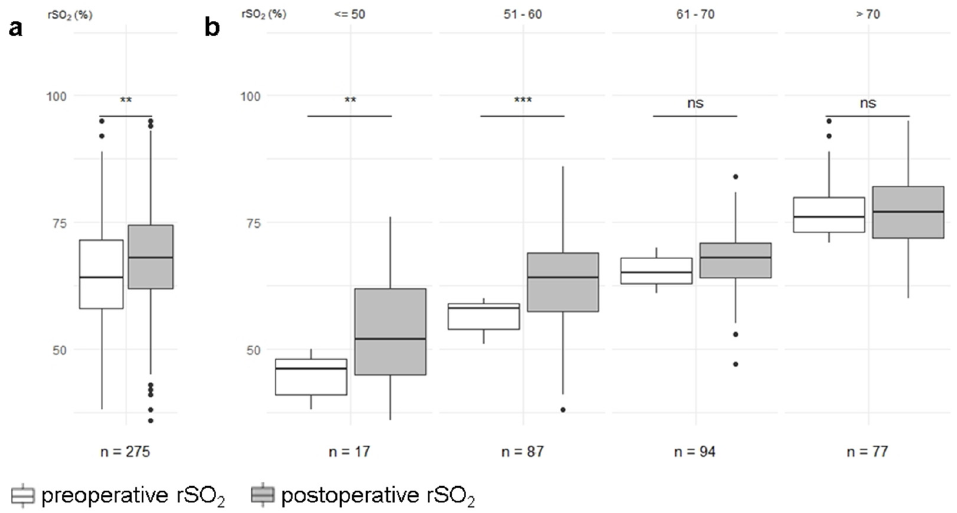
Figure 2. ( a ) Cerebral rSO 2 was enhanced after TAVI. ( b ) Analysis stratified by preoperative values revealed a significant increase only in patients with preoperative rSO 2 ≤ 50% and 51–60%. **: p < 0.01; ***: p < 0.001; ns: not significant; rSO 2 = regional cerebral oxygen saturation.